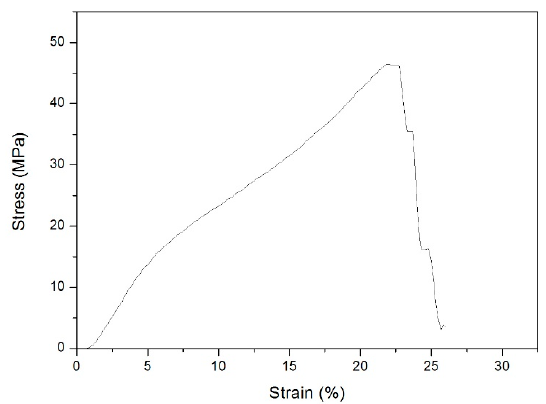
Figure 7. Circumferential tensile stress-strain curve of the PET tubular graft.